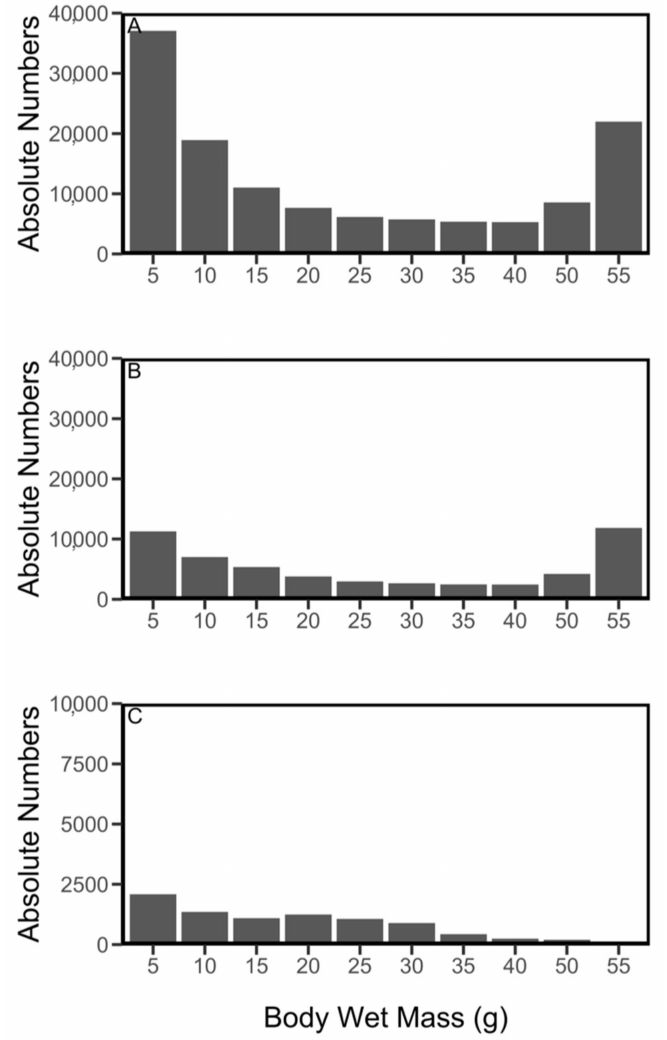
Figure 2. Frequency distributions based on absolute numbers of all sampled fish within 5 g body weight (g) size classes from hydroacoustic surveys, including single-echo detections (SEDs) ( A ), tracked-echo groups (TEGs) ( B ), and pelagic midwater trawl catches ( C ) for survey years between 2006 and 2019 (excluding 2007 and 2016) in Lake Stechlin based on transects of the whole lake